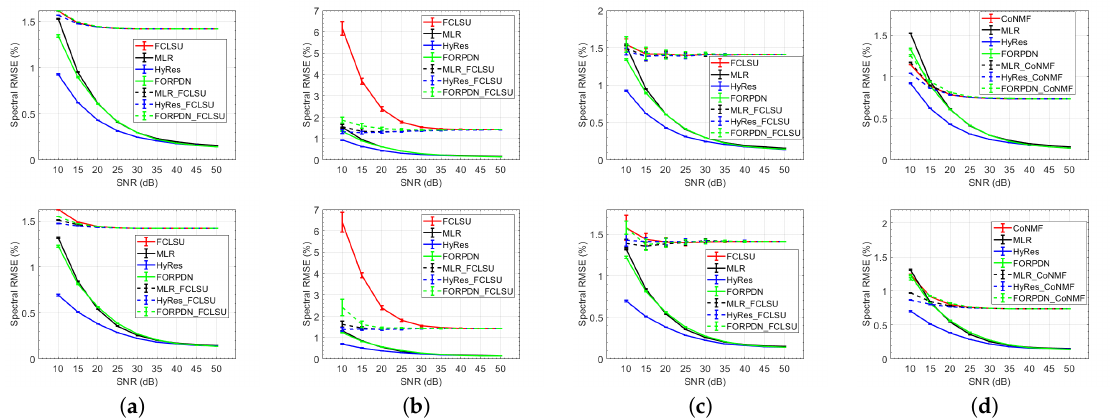
Figure 8. Real data (top row η = ∞ and bottom row η = 18): The denoising performance on the Samson image in terms of Spectral RMSE. ( a ) Ground truth endmembers; ( b ) extracted endmembers; ( c ) library endmembers; ( d ) estimated